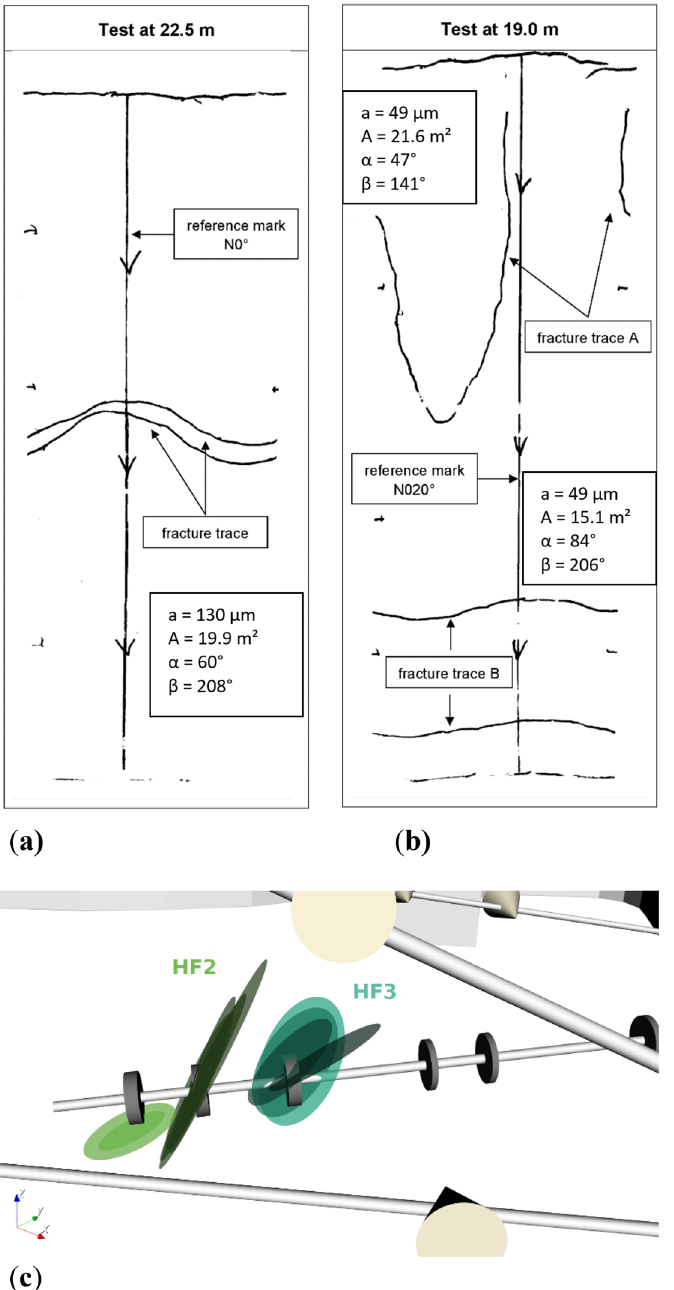
Figure 4. Integrated fracture data from impression packer with interval length of 0.75 m, back flow, and AE hypocentre analysis. Impression packer results shown are ( a ) from conventional test HF2 at a mid-interval depth of 22.5 m and ( b ) from fatigue test HF3 at a mid-interval depth of 19.0 m. Dip (α) and dip direction (β) of the fractures come from impression-packer analysis 48 . Fracture aperture ( a ) and area of fracture plane ( A ) come from AE -hypocentre extension and back-flow data 52 . In ( c ), fracture-plane orientations computed via full- waveform AE analysis are shown 46